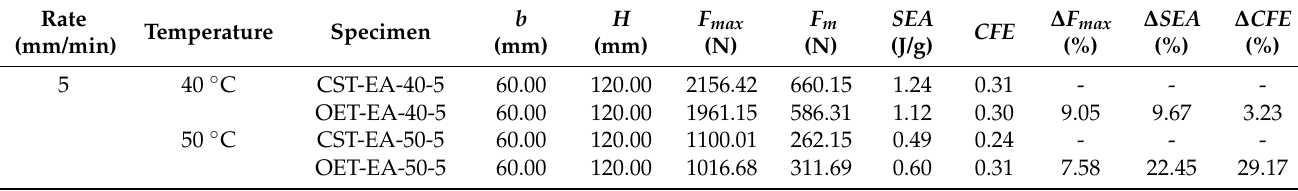
Table 9. Experimental results of OET and CST at 40 ◦ C and 50 ◦